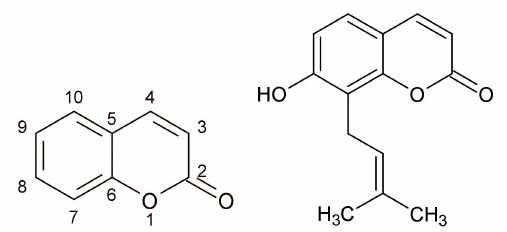
Figure 2. Coumarin ( 2H -chromen-2-one) ( left ) and osthenol ( right